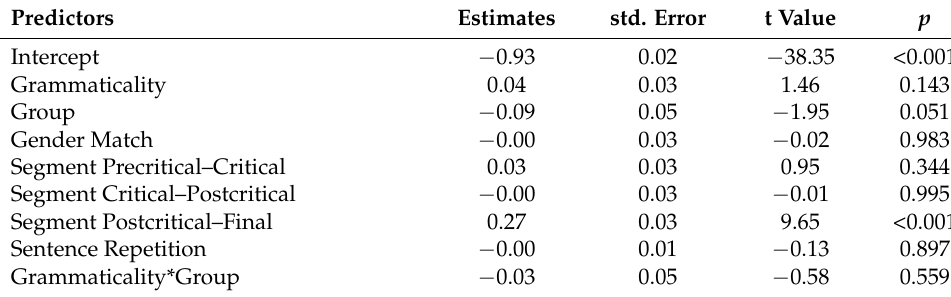
Table A12. Summary of the model for the reaction times and the effect of sentence repetition in the comprehension